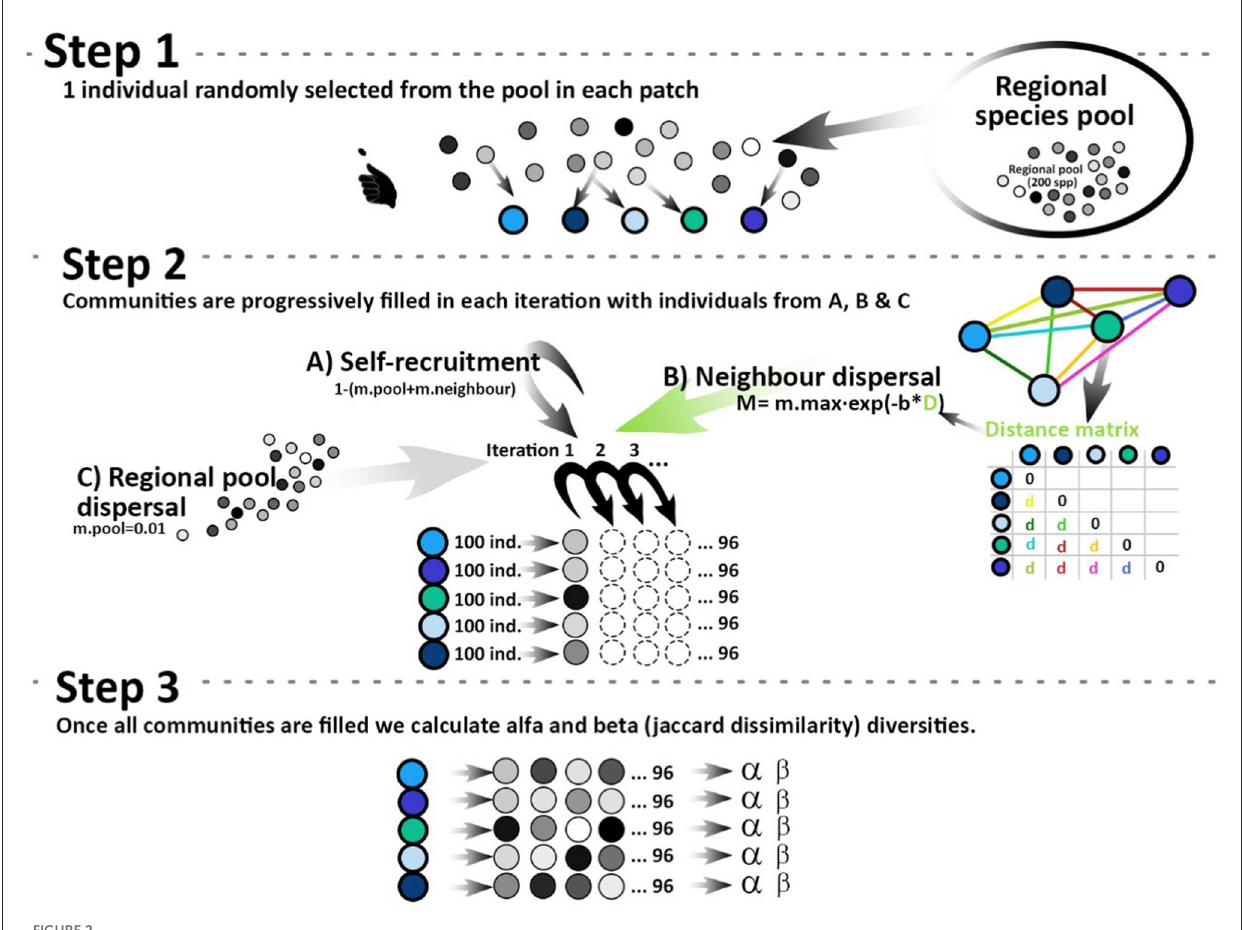
FIGURE2 Conceptual model illustration representing the two main steps of the coalescent model. Step 1: the model starts locating one individual randomly selected from the species pool in each community. Step 2: communities are filled with 100 individuals randomly selected from the (i) species pool, (ii) neighboring communities, or (iii) the same community with probabilities m . pool ( = 0.01), m . neighbour , and 1 − ( m . pool + m . neighbour ), respectively. Migration from neighboring communities is determined by geographic distance ( d ij ) and species dispersal ability ( d 50 ). Step 3: once all communities are filled, alpha and beta diversities are